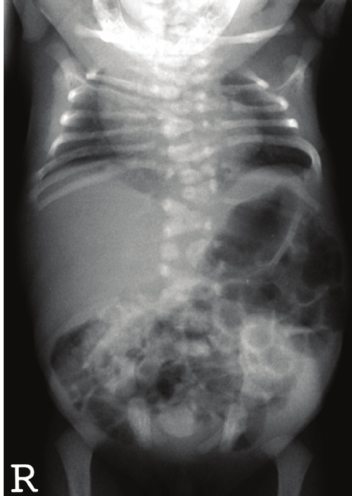
F 5: Radiographic features of spondylocostal dystostosis including contiguous vertebral malformations with asymmetric rib malformations. Photograph courtesy of Peter D. Turnpenny M.D., Royal Devon and Exeter Hospital.